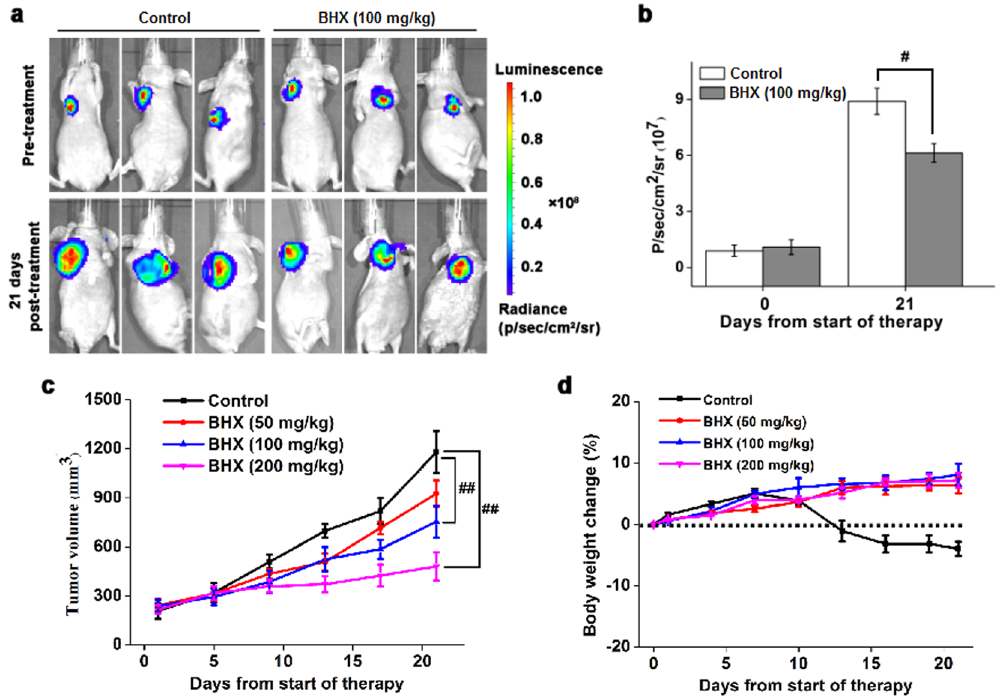
Figure 6. BHX reduces the growth of MDA-MB-231 tumours in vivo . (a) Bioluminescent imaging of MDA-MB-231 tumours at 0 and 21 days after treatment with BHX or vehicle. (b) Quantification of bioluminescent intensity in response to administration of BHX or vehicle after 0 and 21 days of treatment. (c) Tumour volume and (d) body weight were measured every 5 days after treatment with BHX or vehicle. Data are represented as means ± S.D. (n = 5). # p < 0.05 and ## p <